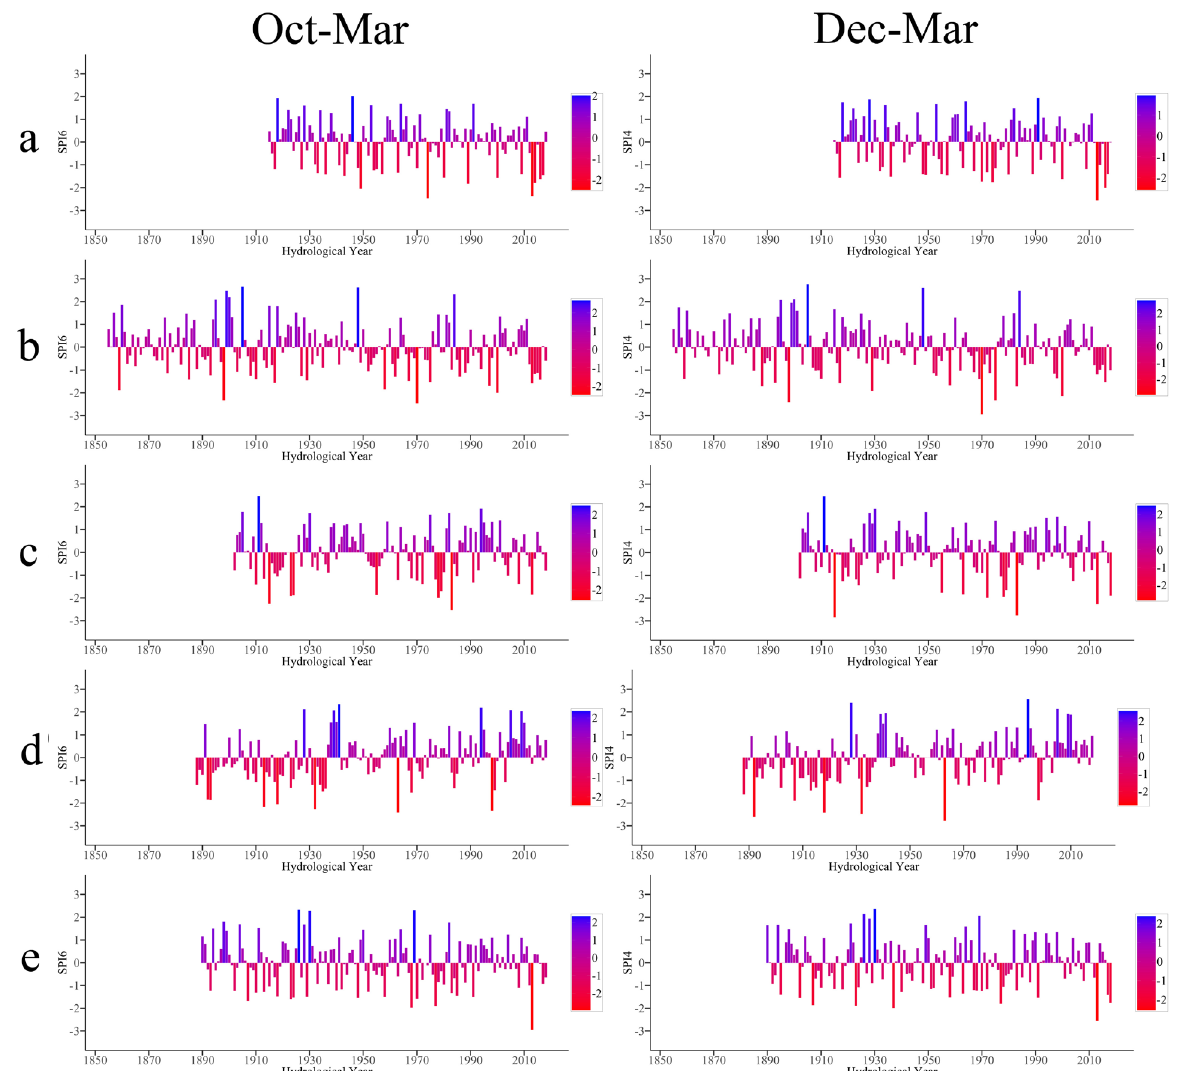
Figure 3. Temporal variability of the SPI6 and SPI4 for the studied locations of southeastern Brazil (a. South-MG; b. MR-BH; c. ME-SP; d. SP city; e.